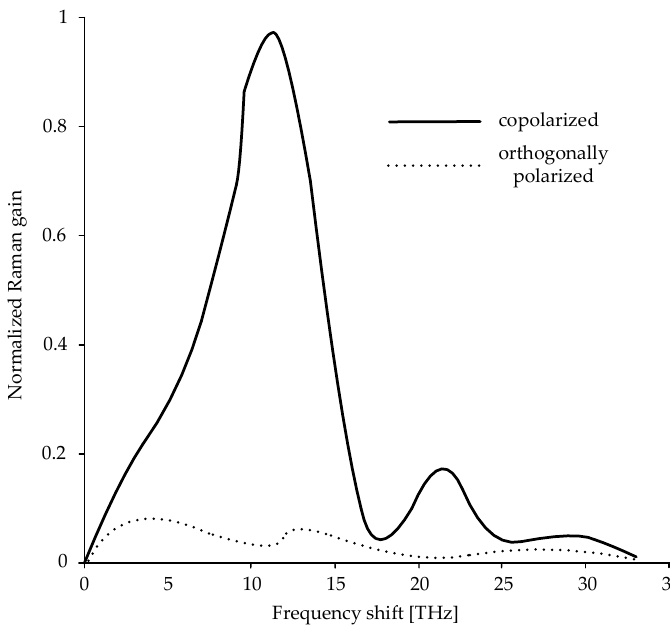
Figure 10. Raman gain for copolarized and orthogonally polarized pump and signal.